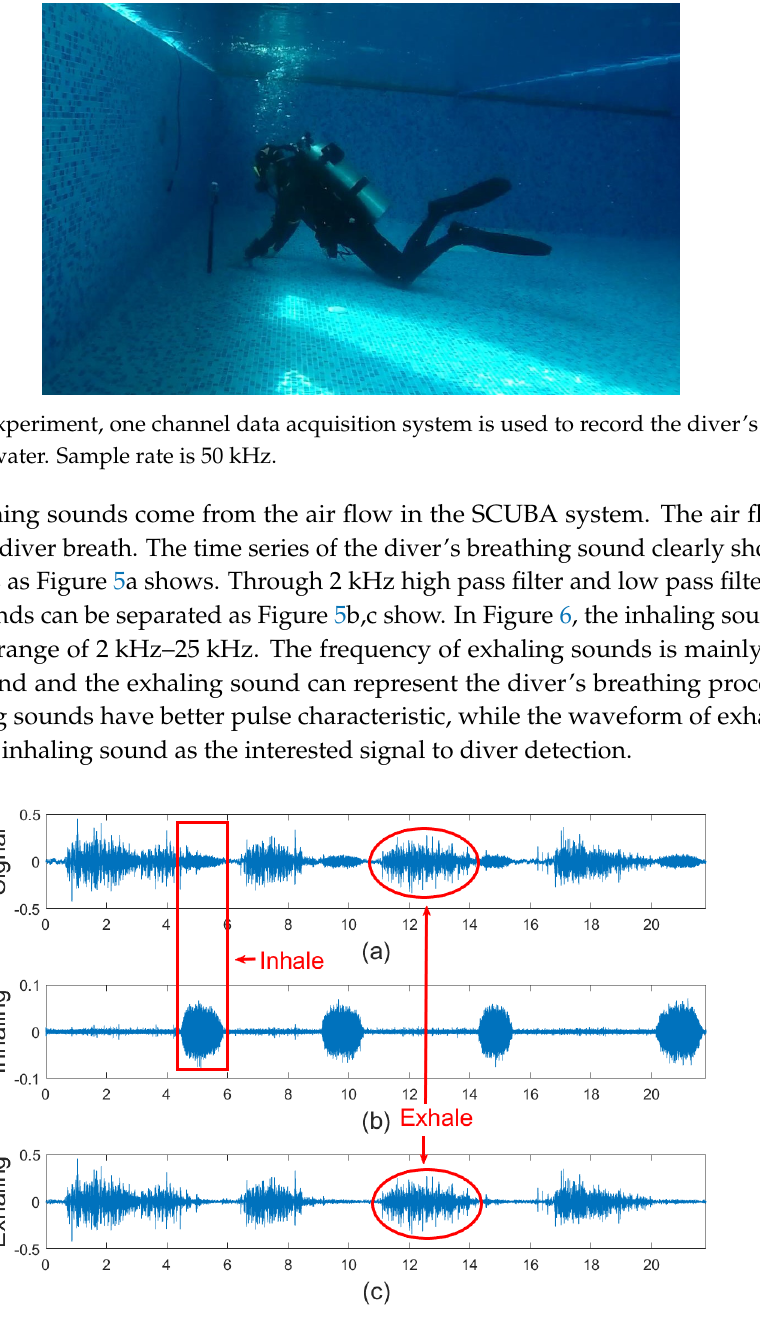
Figure 5. Breathing Sound recorded in experiment. The inhaling and exhaling sound are separated by high-pass and low-pass filters with 2 kHz cutoff frequency. ( a ) original recorded signal; ( b ) high frequency inhaling part of signal; ( c ) low frequency exhaling part of